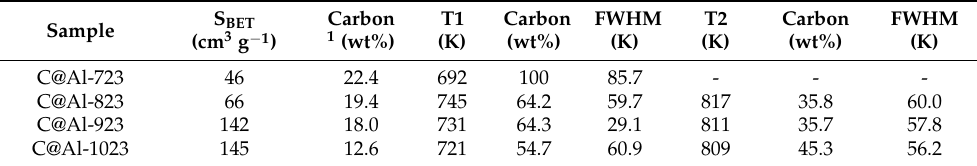
Table 2. Textural properties and thermal stability of the C@Fe–Al 2 O 3 hybrids in